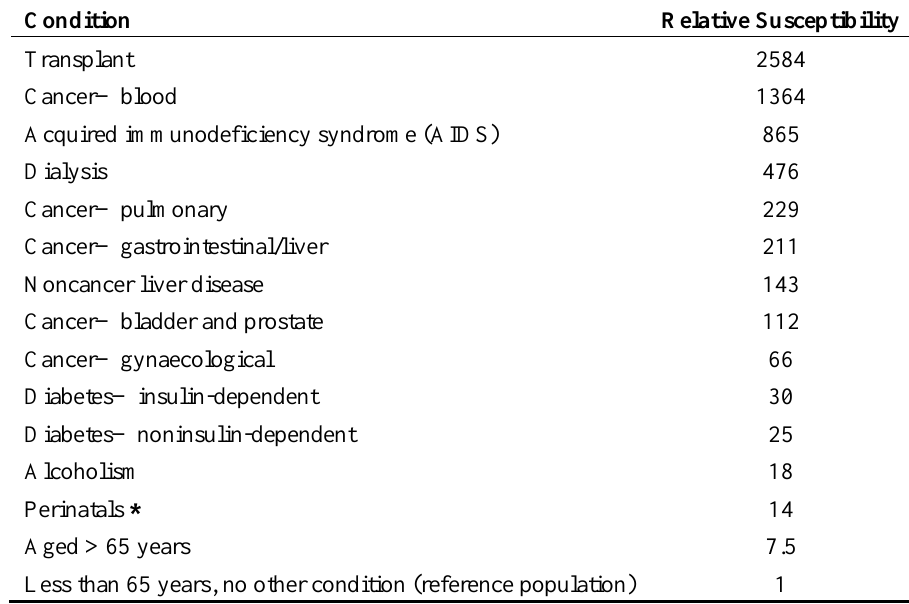
Table 5. Relative susceptibilities of different subpopulations to listeriosis, calculated using relative susceptibility information from France. Data from